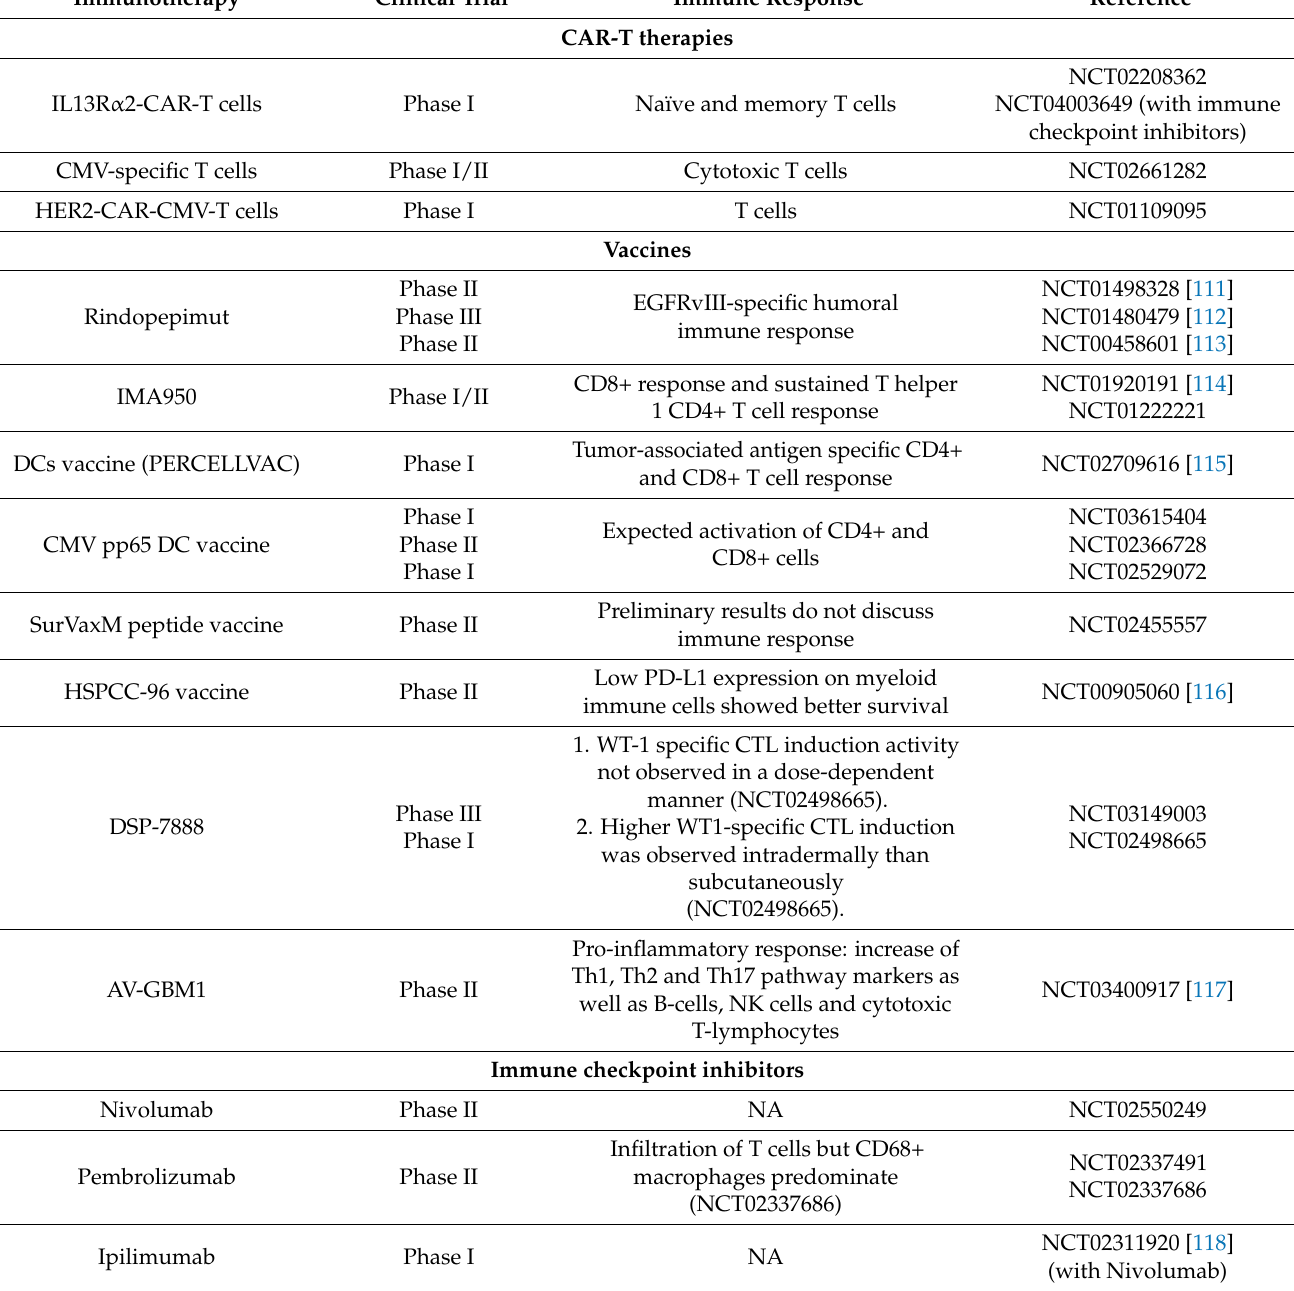
Table 2. Currently available immunotherapies against